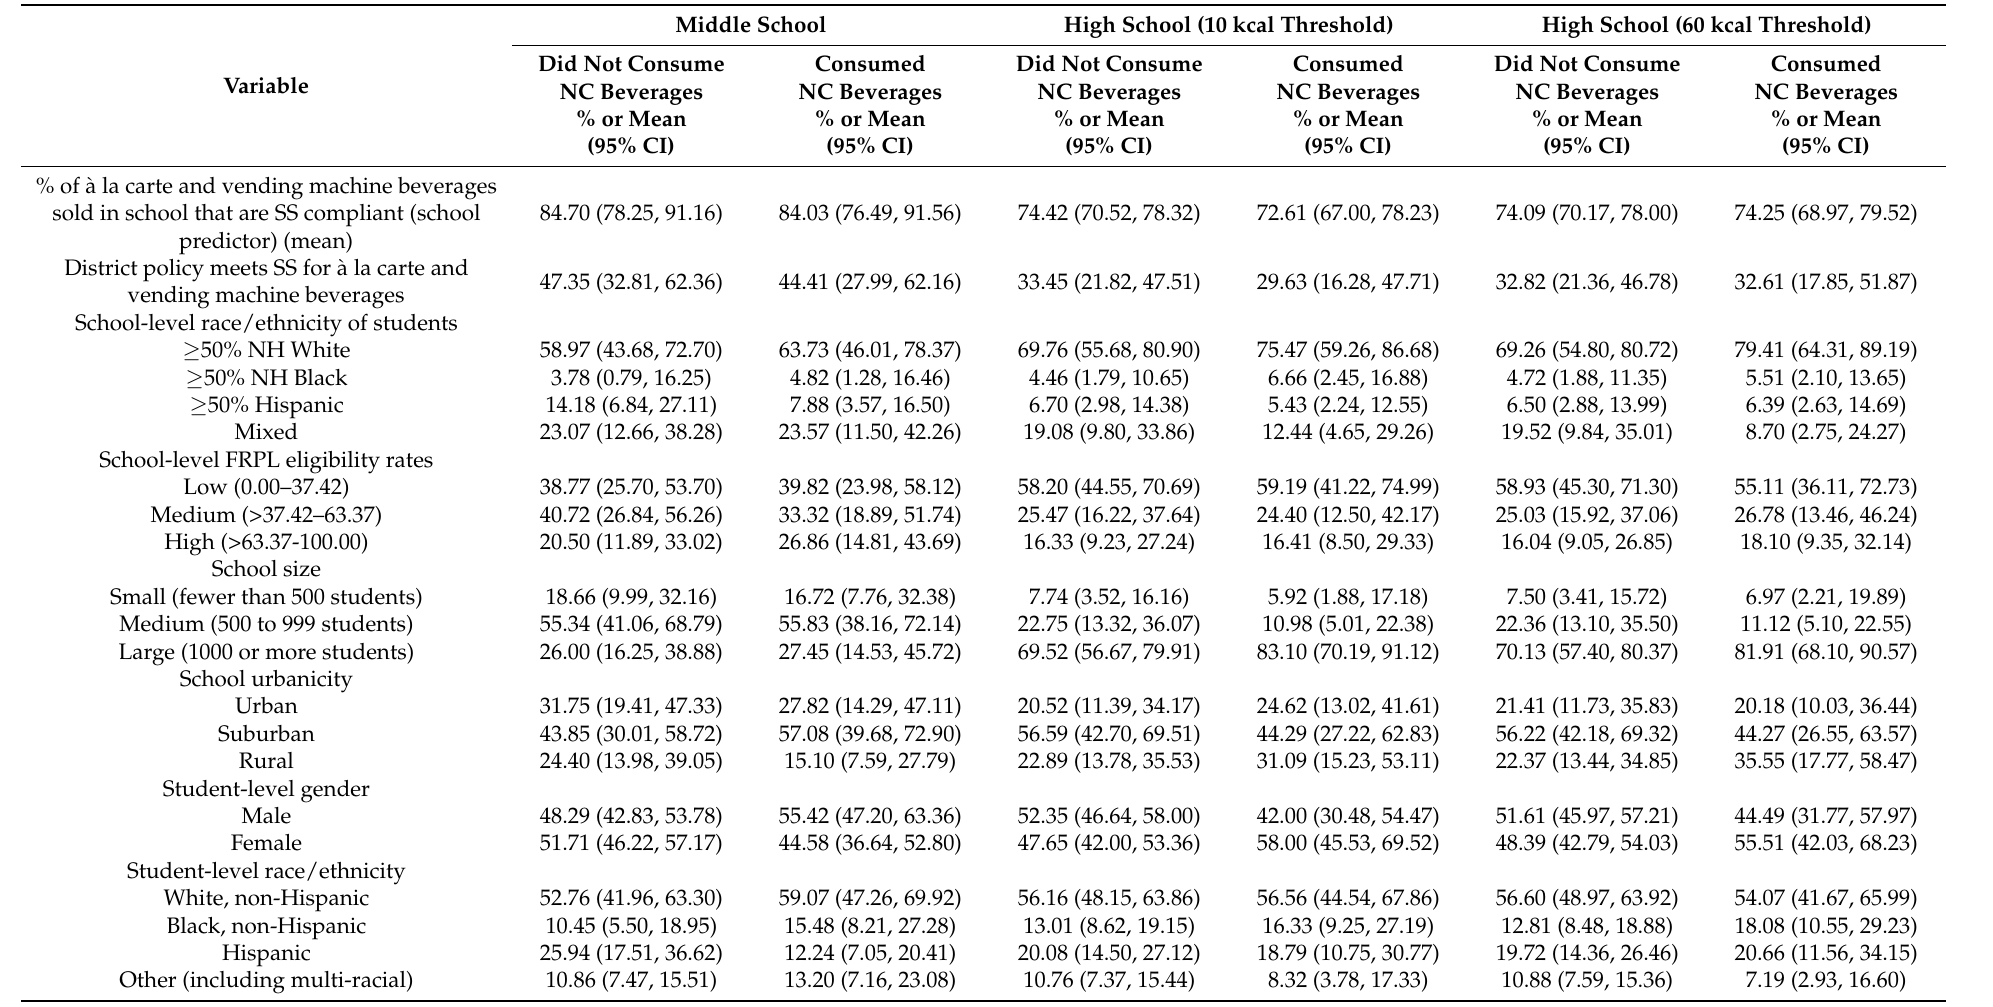
Table A3. Survey-weighted characteristics of the analytic sample of students who consumed and did not consume Smart Snacks non-compliant (NC) beverages by school